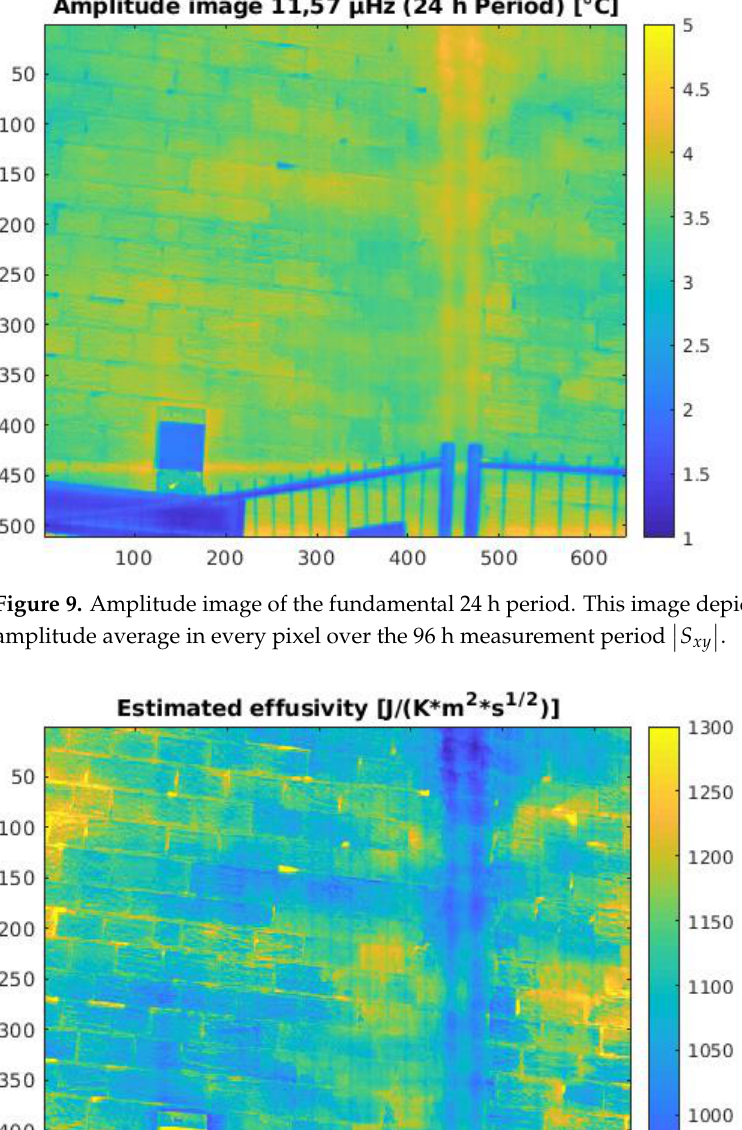
Figure 8. Average surface temperature for the ROIs depicted above. Noticeable is the greater tem- perature difference of the Al10 plate vs the Al20 plate, caused by the lower thermal mass.